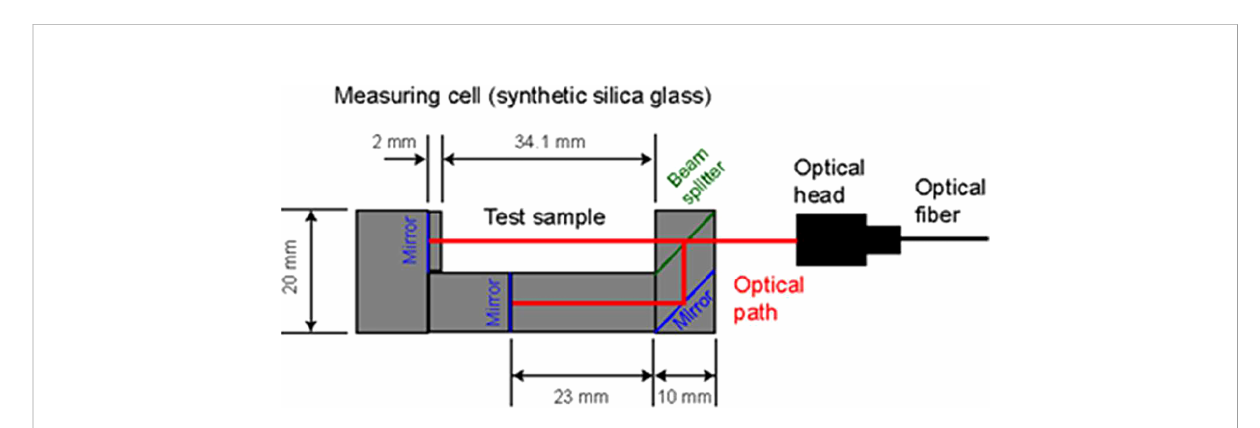
FIGURE 10 Scheme of the measuring cell (from Uchida et al.,